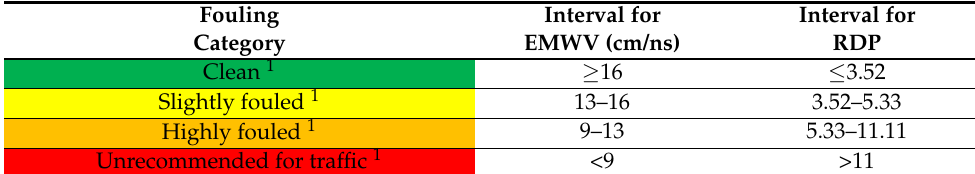
Table 7. Suggested fouling intervals for granite railway Table 8. Suggested fouling intervals for granite railway ballast.